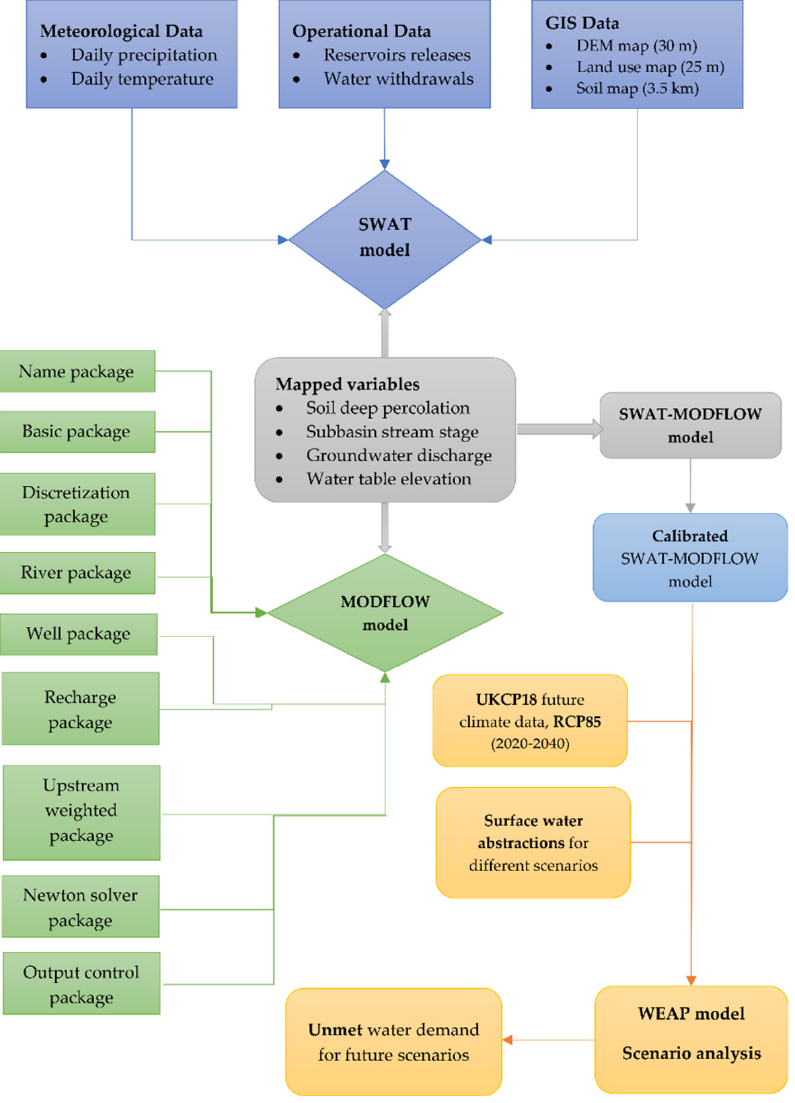
Figure 4. Flowchart illustrating the coupled SWAT-MODFLOW-WEAP model with climate model of UKCP18 for different scenarios of water demands for River Dee watershed.